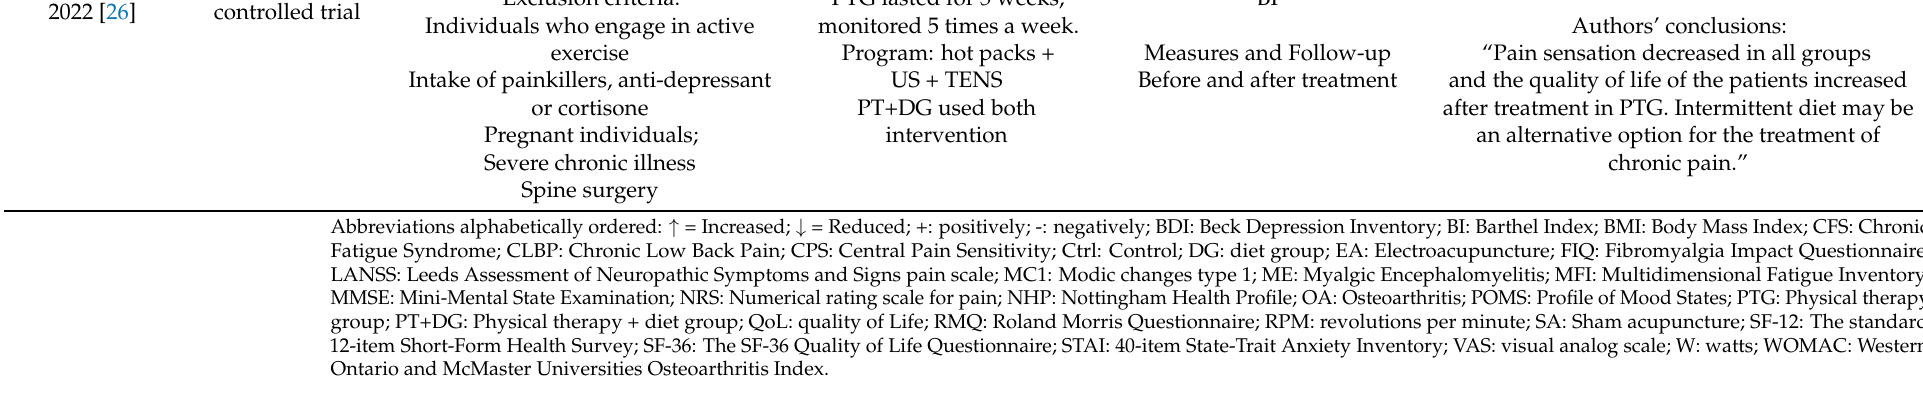
Table 2. Methodological quality evaluation of the clinical trials using the PEDro scale in randomized